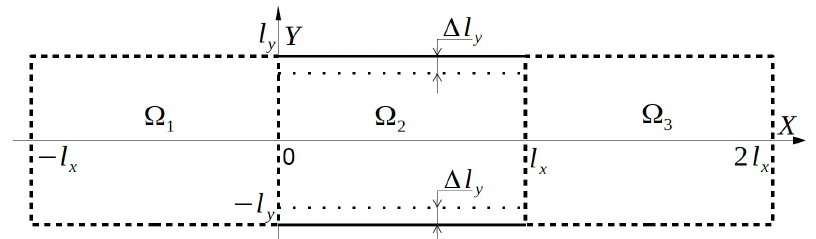
Figure 1. Geometrical configuration of the molecular dynamics model of the through-type